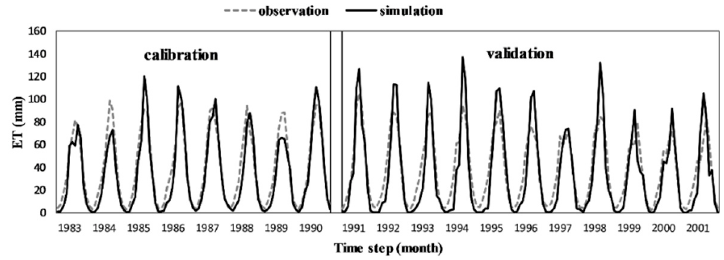
Figure 4. The monthly observed and simulated ET(Evapotranspiration) at CRB(Chaobai River Basin) during calibration and validation periods.